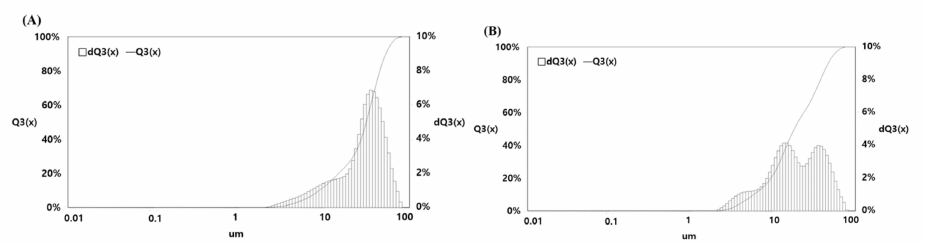
Figure 3. Measuring the particle size distribution of MUL. ( A ) MUL: 29.81 ± 13.80 µ m, ( B ) MUL- ESFs-CA-ALG: 23.22 ± 0.26 µ m.